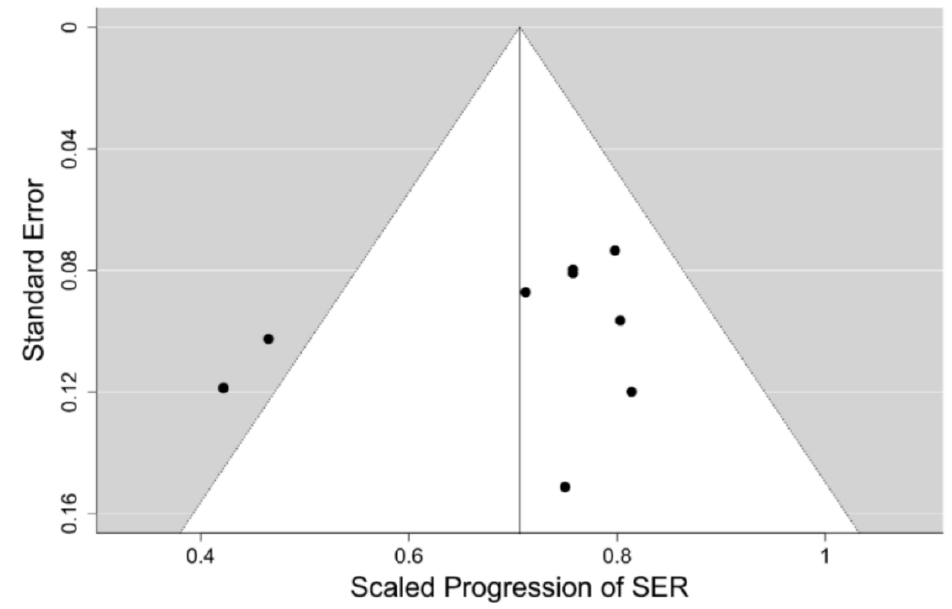
Figure 7. Funnel plot for the scaled progression of sphere equivalent refraction (SER) at the 12- months follow-up in the model for the 9 interventions using soft multifocal contact lenses to control progression of